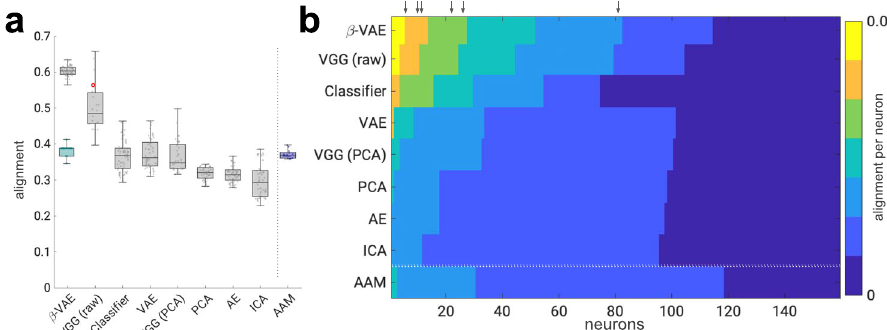
Fig. 4 Disentangled latent units align with single neurons better than baselines. a Alignment scores are signi fi cantly higher for the β -VAE than the baseline models and the “ gold standard ” provided by the AAM (all p < 0.01, two-sided Welsch ’ s t -test; VGG (raw) p = 7.4220 e – 06, Classi fi er p = 0.0, AAM p = 9.1757 e – 42, VAE p = 9.7811 e – 43, VGG (PCA) p = 1.9383 e – 35, PCA p = 0.0, AE p = 0.0, ICA p = 0.0). Circles, alignment per model ( β -VAE, n = 51; VGG (raw), n = 22; Classi fi er, n = 64; VAE, Variational AutoEncoder 36 , n = 50; AE, AutoEncoder 35 , n = 50; VGG (PCA) 32 , n = 41; PCA, n = 41; ICA, n = 50; AAM, active appearance model 3 , n = 21). Red circle indicates VGG (raw) with all N = 4096 units from the last hidden layer. Teal boxplot — random baseline with sparseness matched to the 51 β -VAE models. Boxplot centre is median, box extends to 25th and 75th percentiles, whiskers extend to the most extreme data that are not considered outliers, outliers are plotted individually. Source data are provided as a Source Data fi le. b Per-neuron alignment scores. Scores are discretised into equally spaced bins. Scores in each row are arranged in descending order. The results from single models, chosen to have the median alignment score. VGG (raw) results are presented from the model that contained all N = 4096 units from the last hidden layer. Arrows point to neurons from Fig. 2b within the β -VAE alignment scores. Source data are provided as a Source Data fi